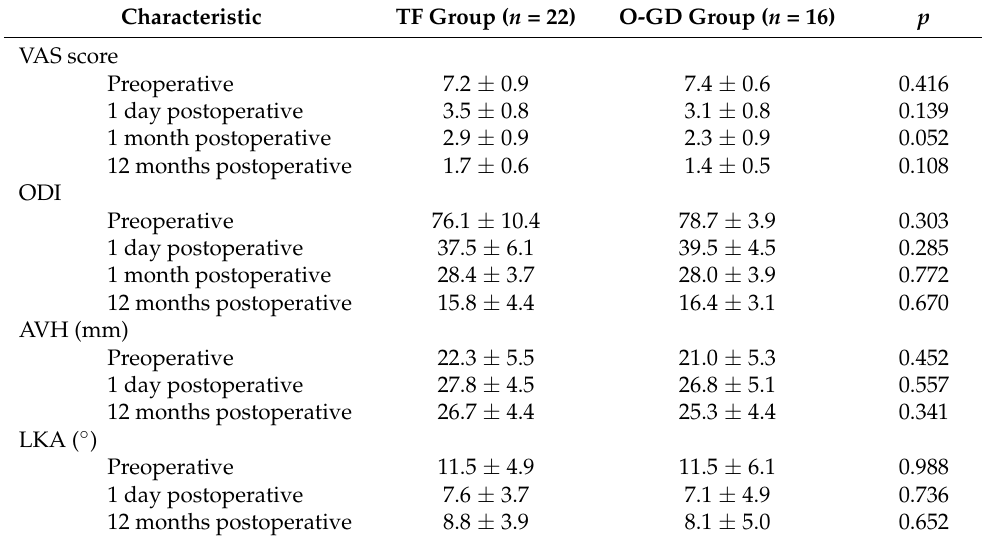
Table 3. Comparison of changes in clinical and radiographic parameters between the 2 groups.